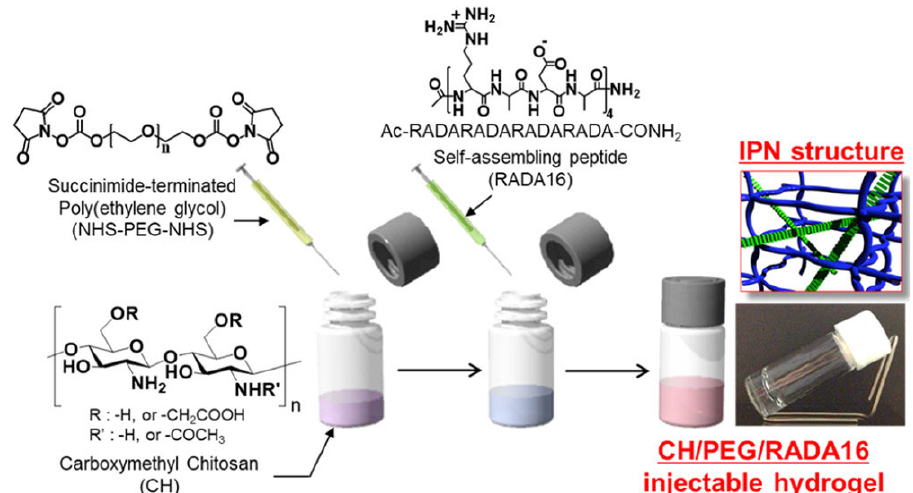
Figure 8. Schematic illustration of the “One-Pot” synthesis of the CH/PEG/RADA16 injectable hy- drogel, with the IPN structure. Reprinted with permission from Ref. [104] Copyright 2015, American Chemical Society.